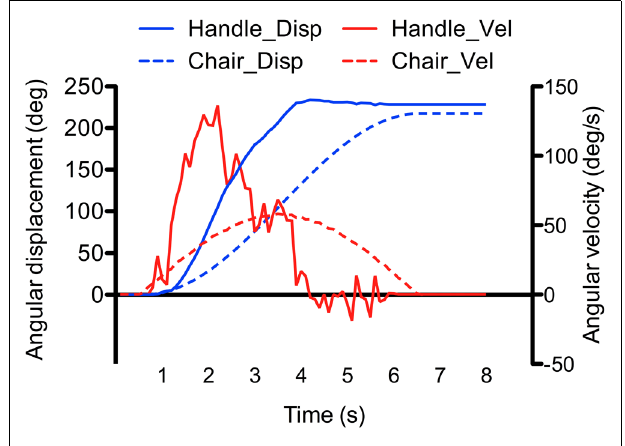
FIGURE 3 | Example of recorded angular displacement and velocity of the chair and manipulandumss handle (the example was taken from theAccLow-DecLow condition which rotated the participant by 220 ◦ ).